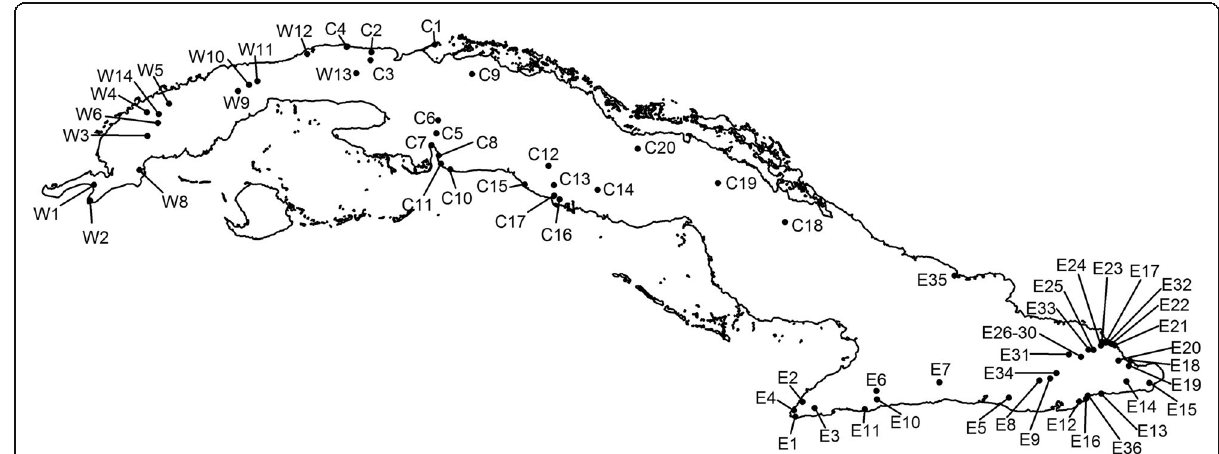
Fig. 1 Map of Cuba showing sample locations; Additional file 1: Table S1 contains more detailed information regarding these